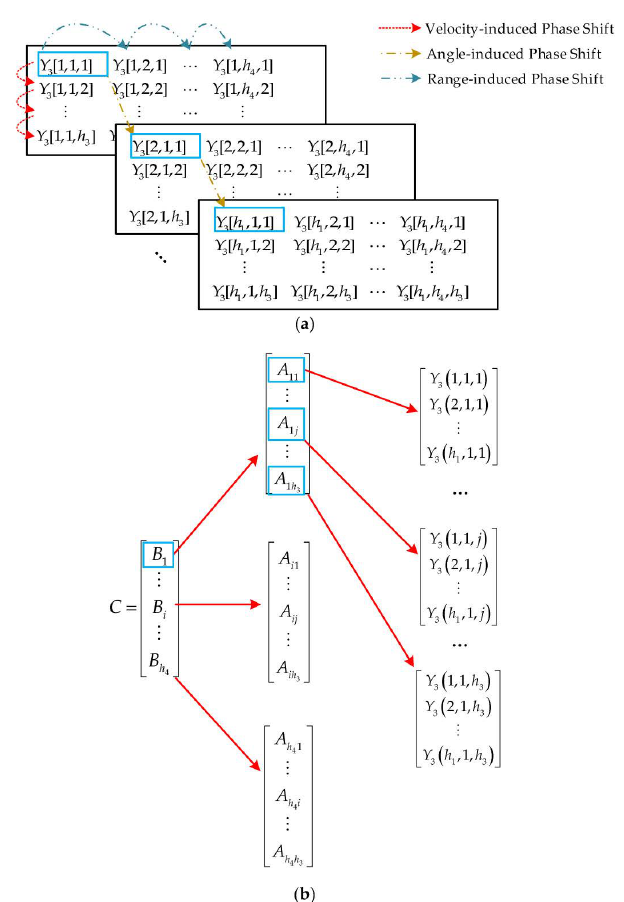
Figure 5. Understanding of the 3D steering vector C , ( a ) three kinds of phase shifts, ( b ) constructions of vector